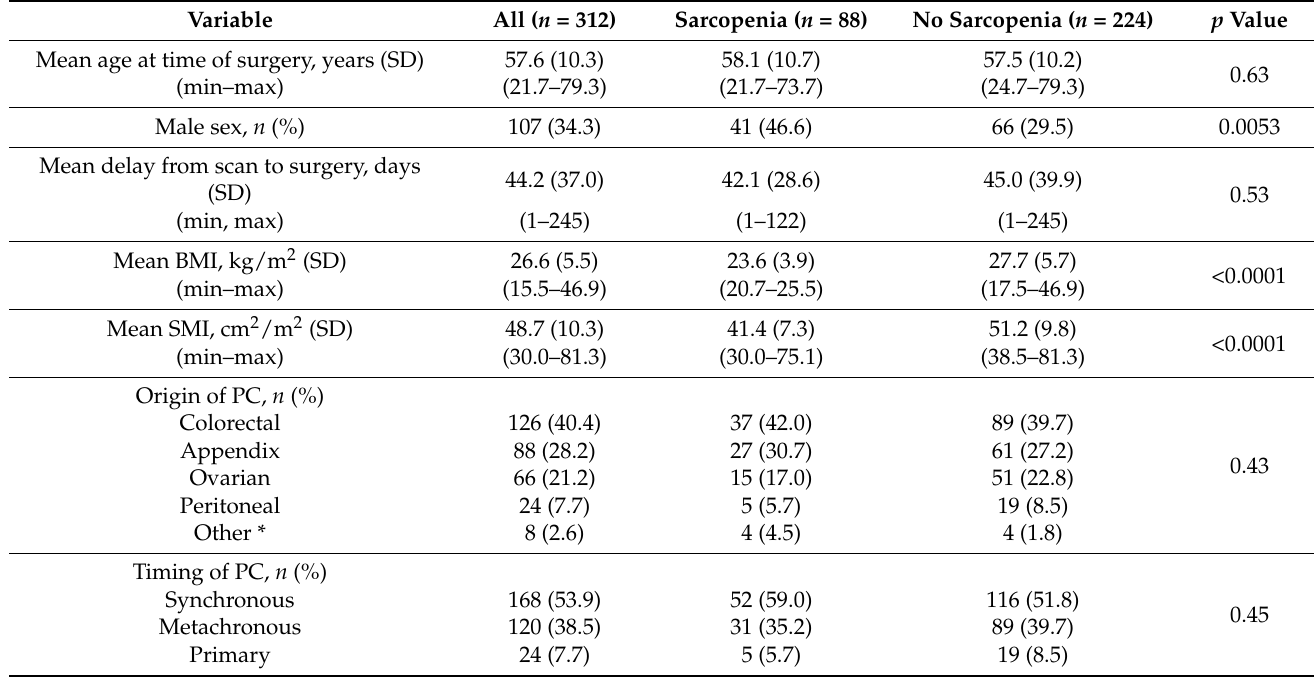
Figure 2. Flow chart of patient inclusion and exclusion. Table 1. Patient Baseline Demographic and Clinical Characteristics .